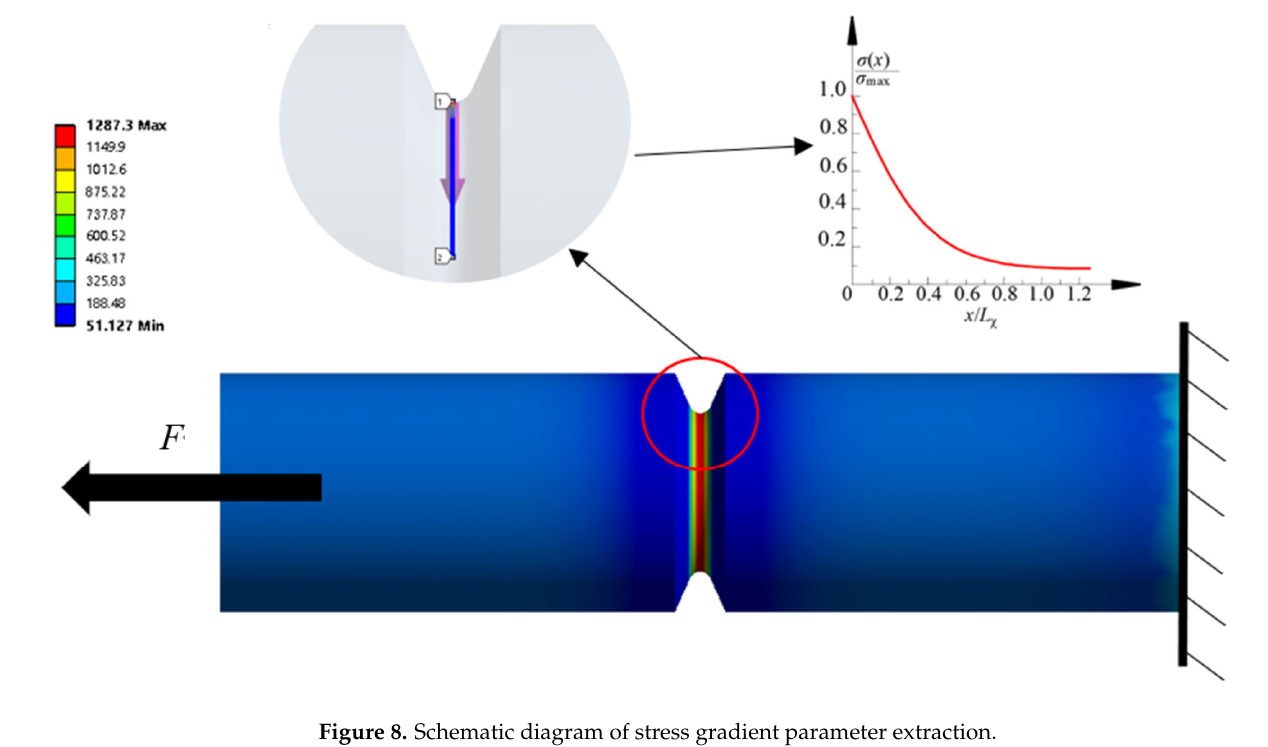
Figure 8. Schematic diagram of stress gradient parameter extraction.